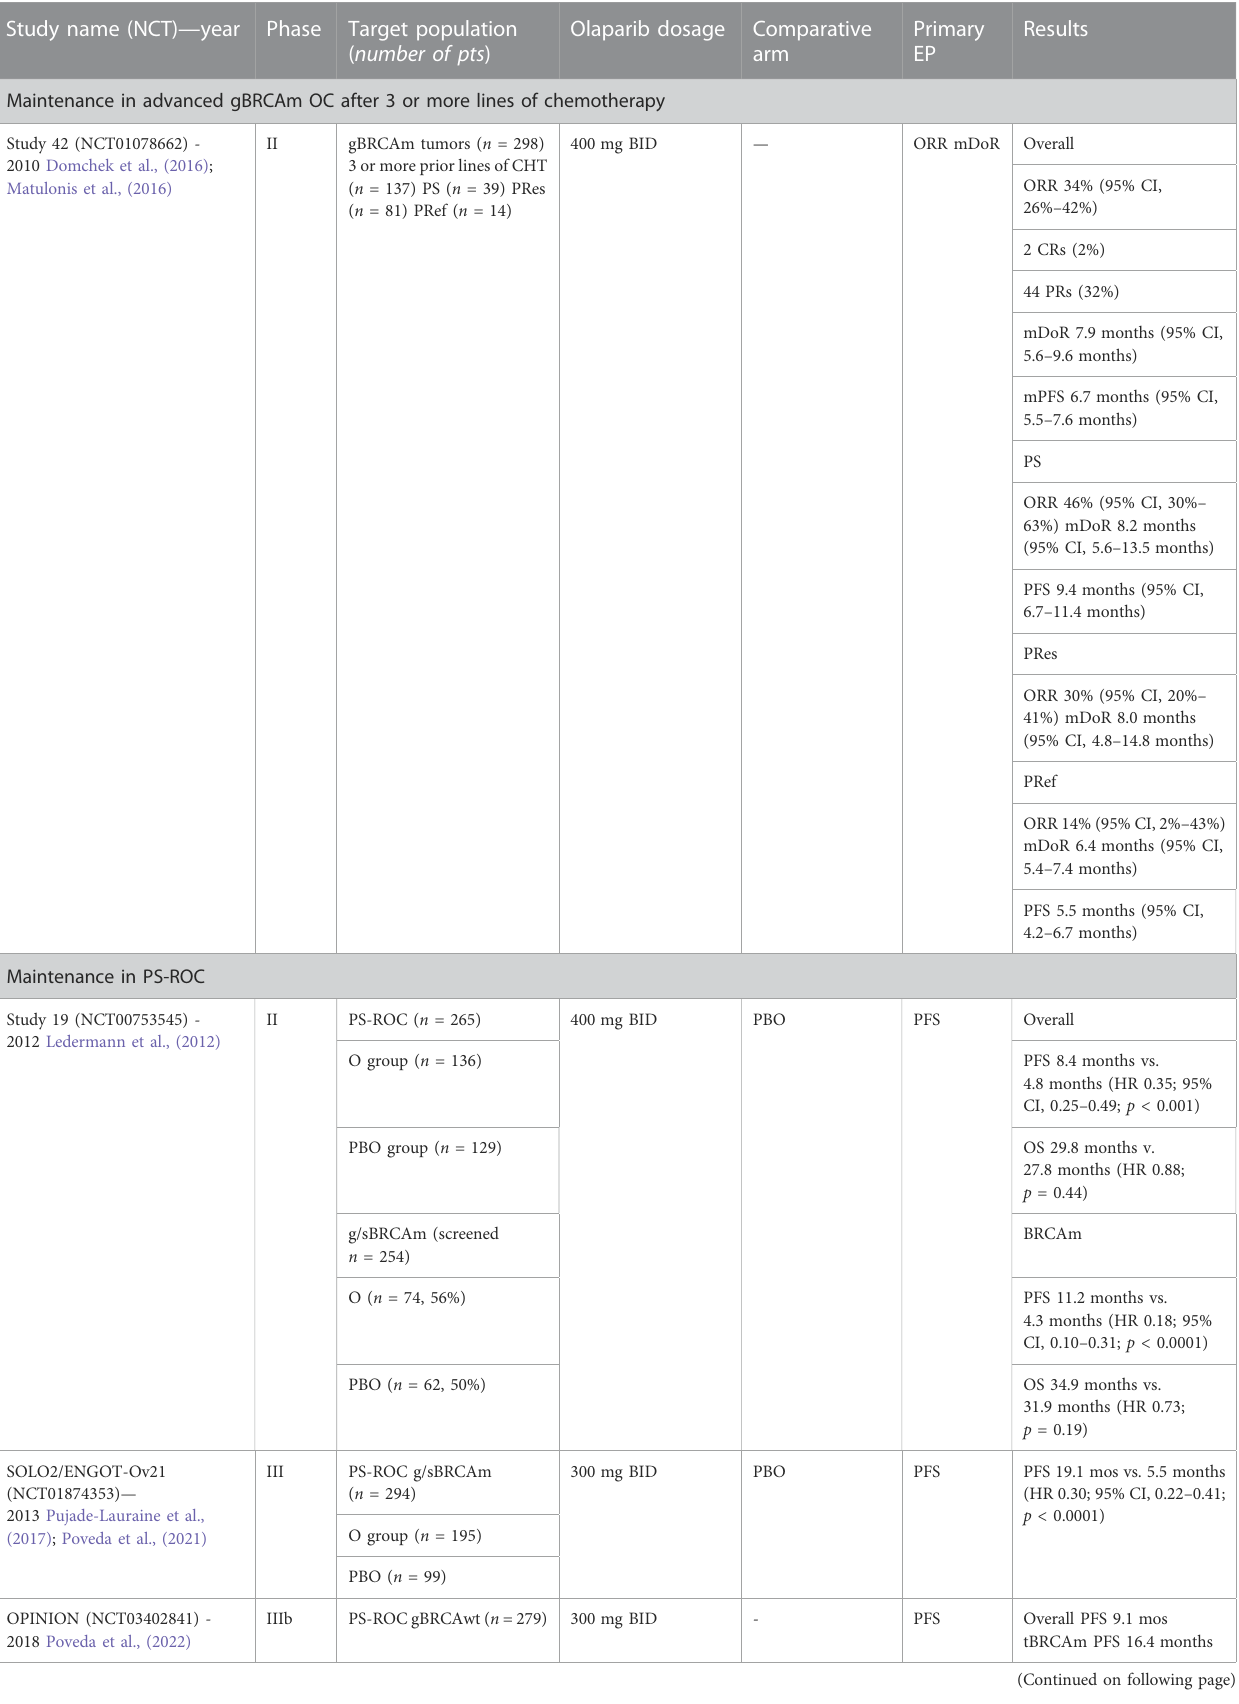
TABLE 2 Summary of studies employing Olaparib as maintenance in advanced OC. Study name (NCT) — year Phase Target population Maintenance in advanced gBRCAm OC after 3 or more lines of chemotherapy Study 42 (NCT01078662) - 2010 Domchek et al., (2016); Matulonis et al.,